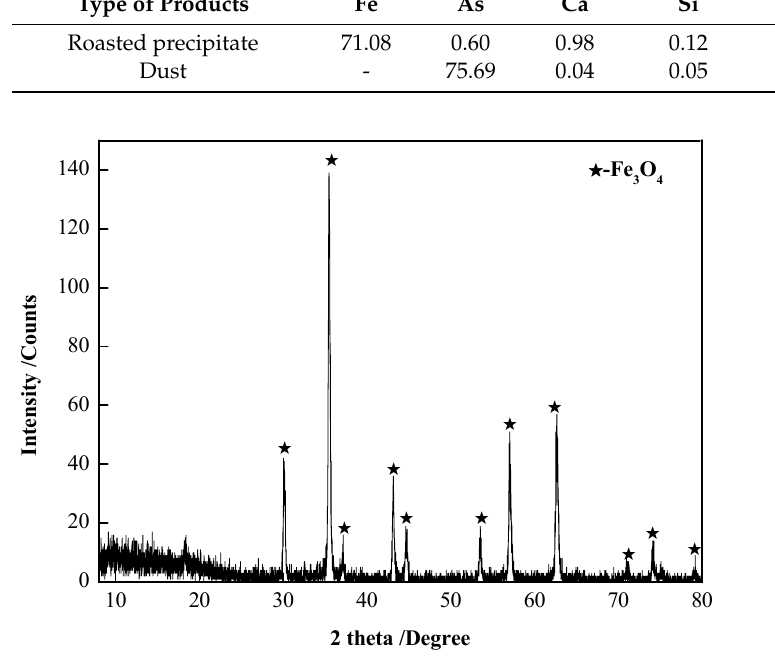
Figure 17. XRD patterns of the roasted precipitate.